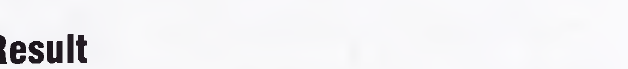
Table 1 : Mean scores for stress levels during Tests 1 , 2 , 3 & 4 among all